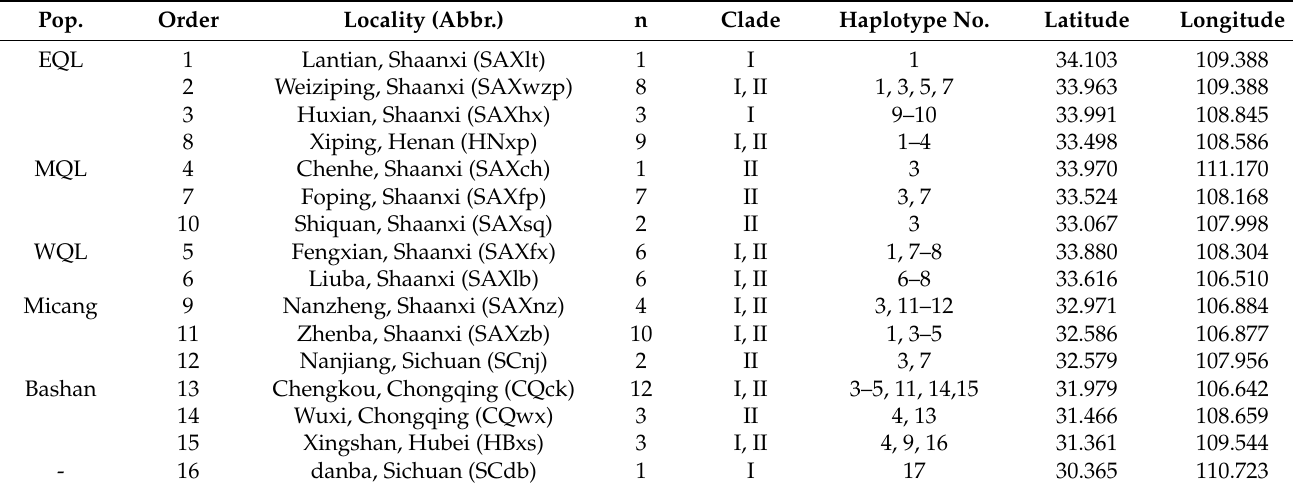
Table 1. Sampling information for Sus scrofa in this study.